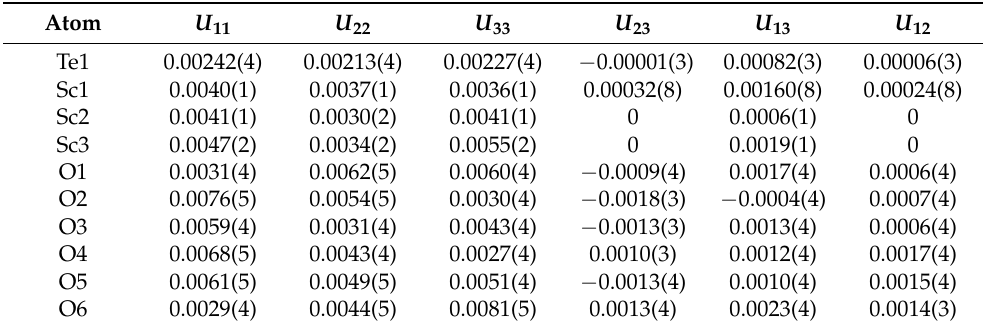
Table 3. Anisotropic displacement parameters U ij (Å 2 ) 1 for HP-Sc 2 TeO 6 (space group P 2/ c ; no. 13). Standard deviations in